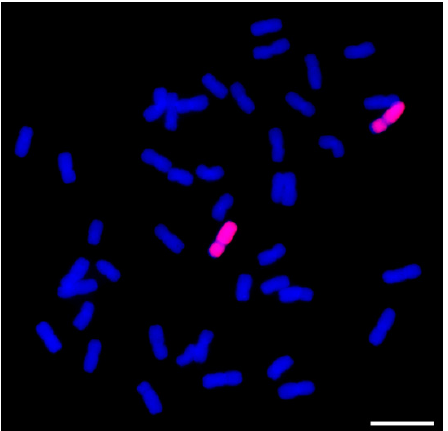
Int. J. Mol. Sci. 2022 , 23 , 7370 Figure 1. GISH results of wheat– A. cristatum 2P addition line II-9-3. Probe: A. cristatum genomic DNA. Block: wheat genomic DNA from Fukuho. Bar = 5 μ m.